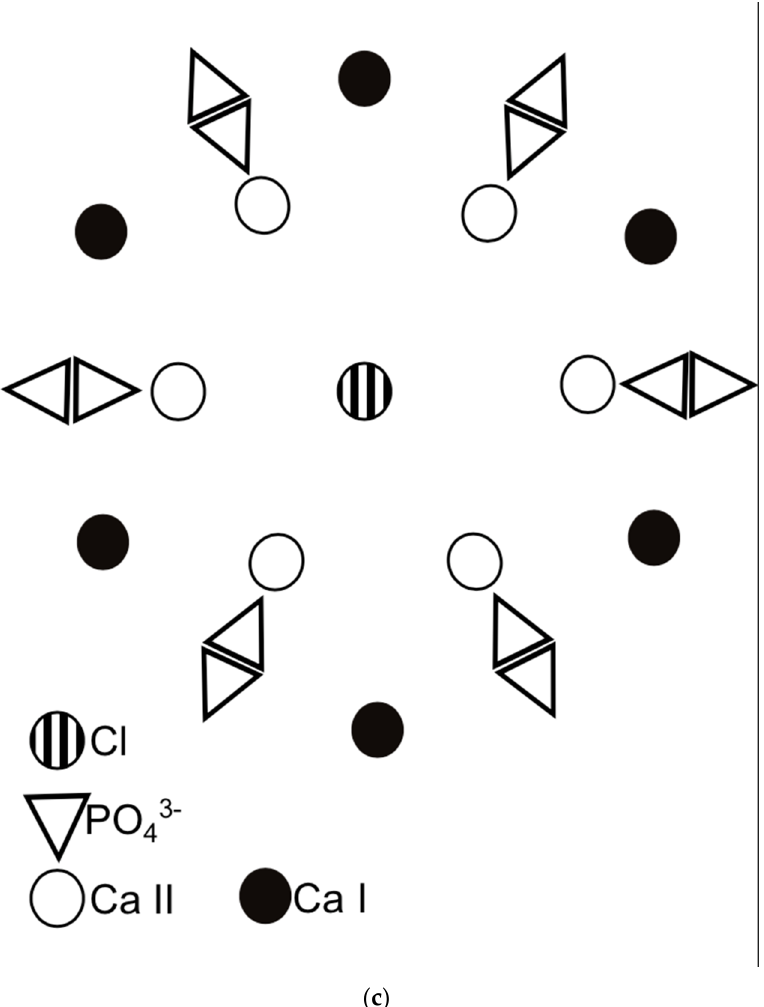
Figure A1. ( a ) Model of the crystal of “overbuilt” apatite in position close to DEJ, centered around hexad axis; Na and CO 32 − ions are symmetrically located, while Mg in asymmetric way; OH − ion is present. ( b ) asymmetric version; ( c ) on the boundary enamel-air, all Ca(2) ions and phosphates are present, Cl entered the cell.